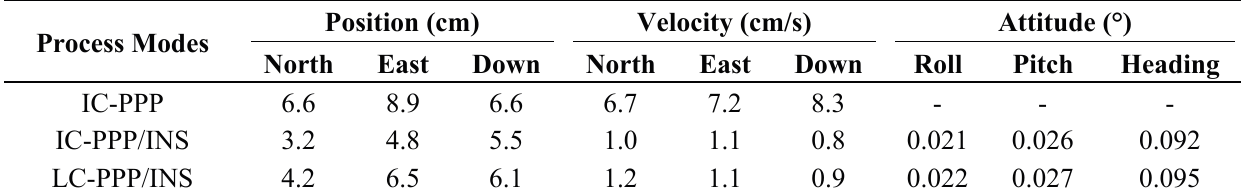
Table 2. RMS of the position, velocity, and attitude of the three processing schemes with respect to the reference solution using NovAtel IE software.